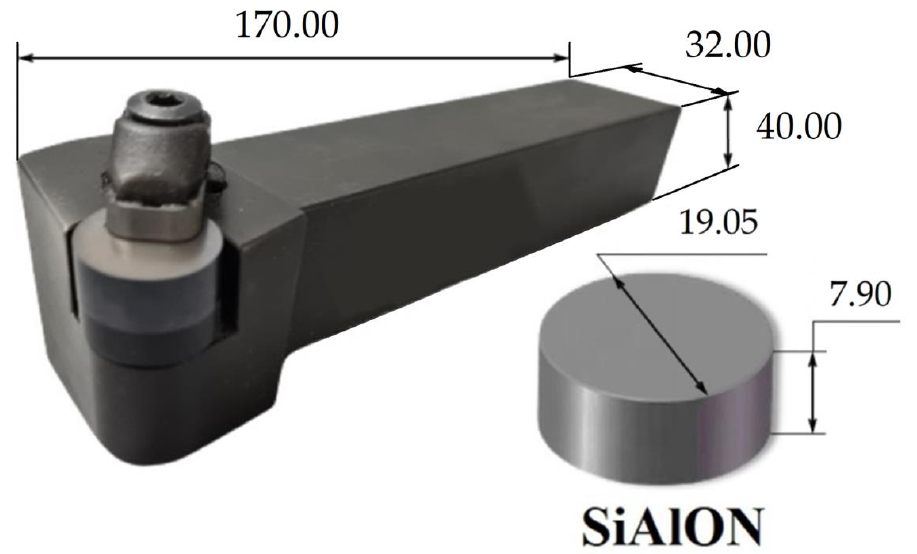
Figure 2. Design of a prefabricated turning cutter with mechanically fastened round ceramic inserts used in experiments.